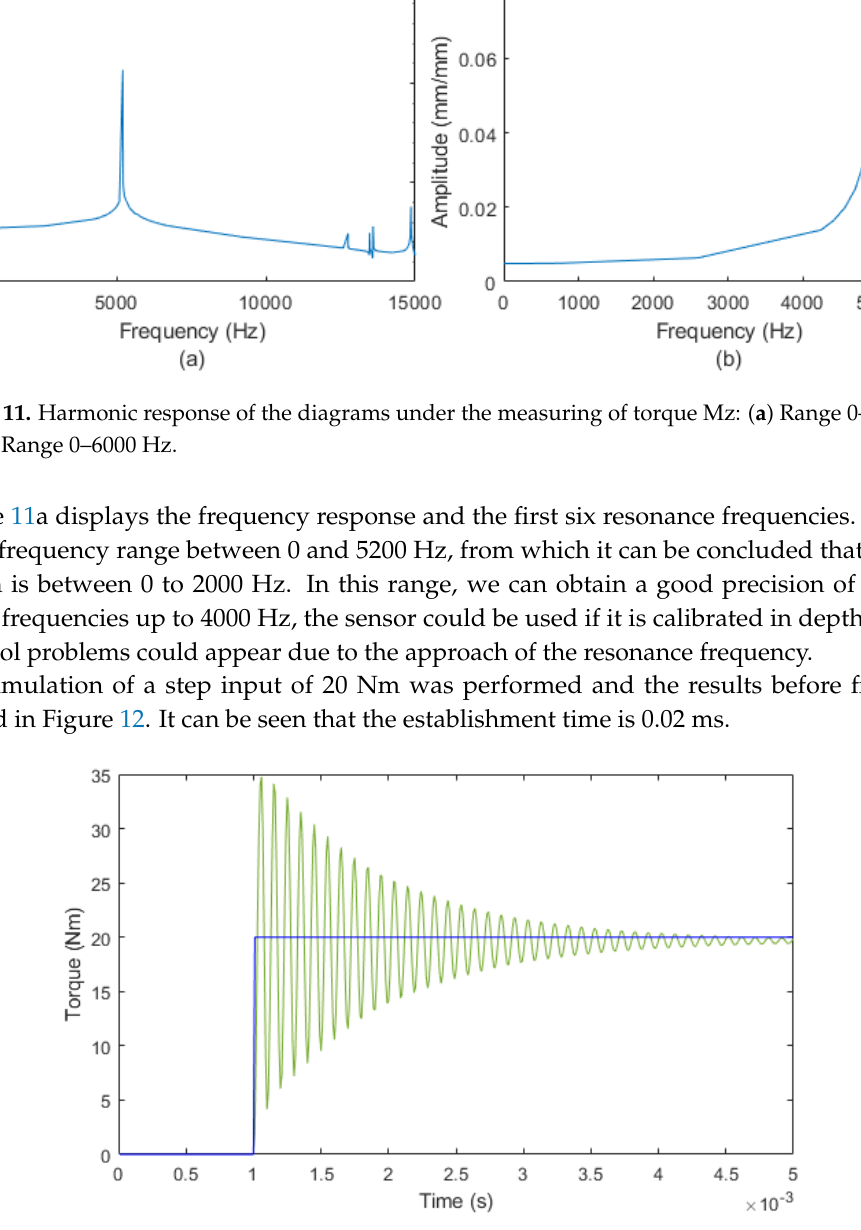
Figure 12. Time response of the sensor with a step input of 20 Nm.